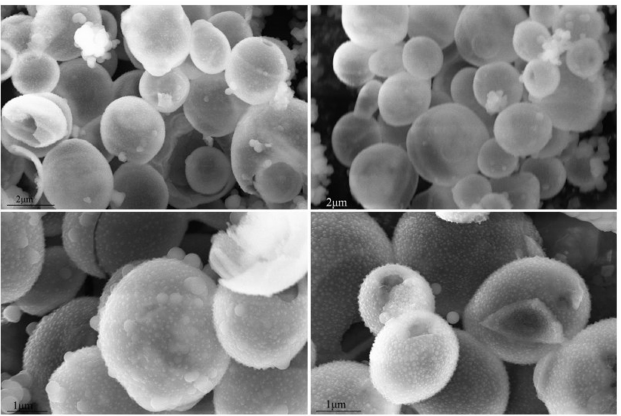
Figure A4. SEM images of TiO 2 prepared from P. pastoris GS115 as a